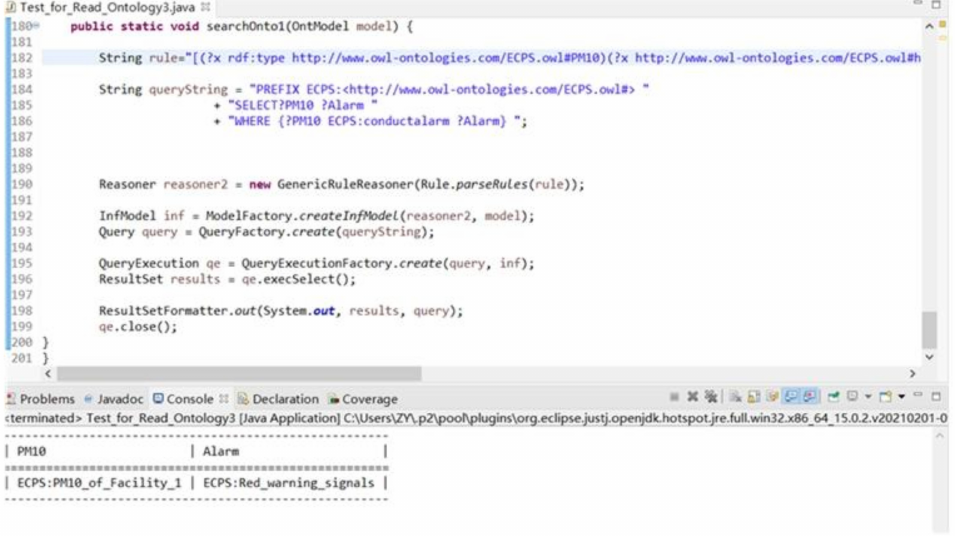
Figure 5. PM10 warning inference program